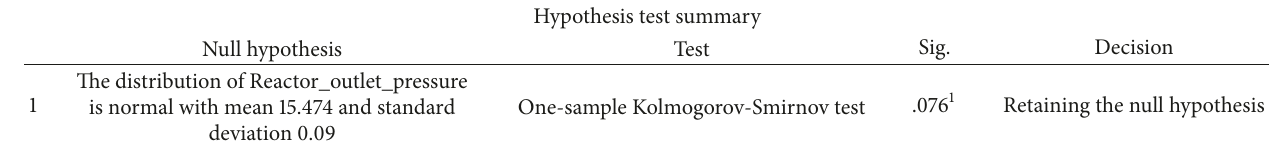
Table 8: Nonparametric tests summary of reactor outlet pressure.